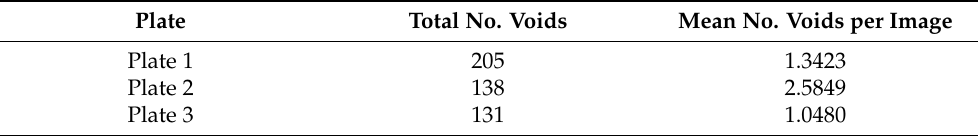
Table 15. Void data information for the three plates.